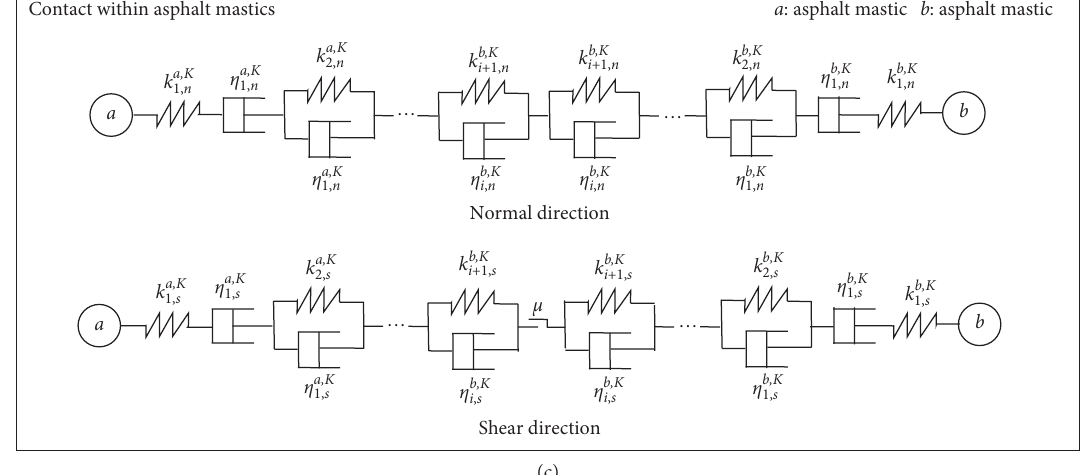
Figure 4: Constitutive relation of contacts in numerical samples using the K-model.